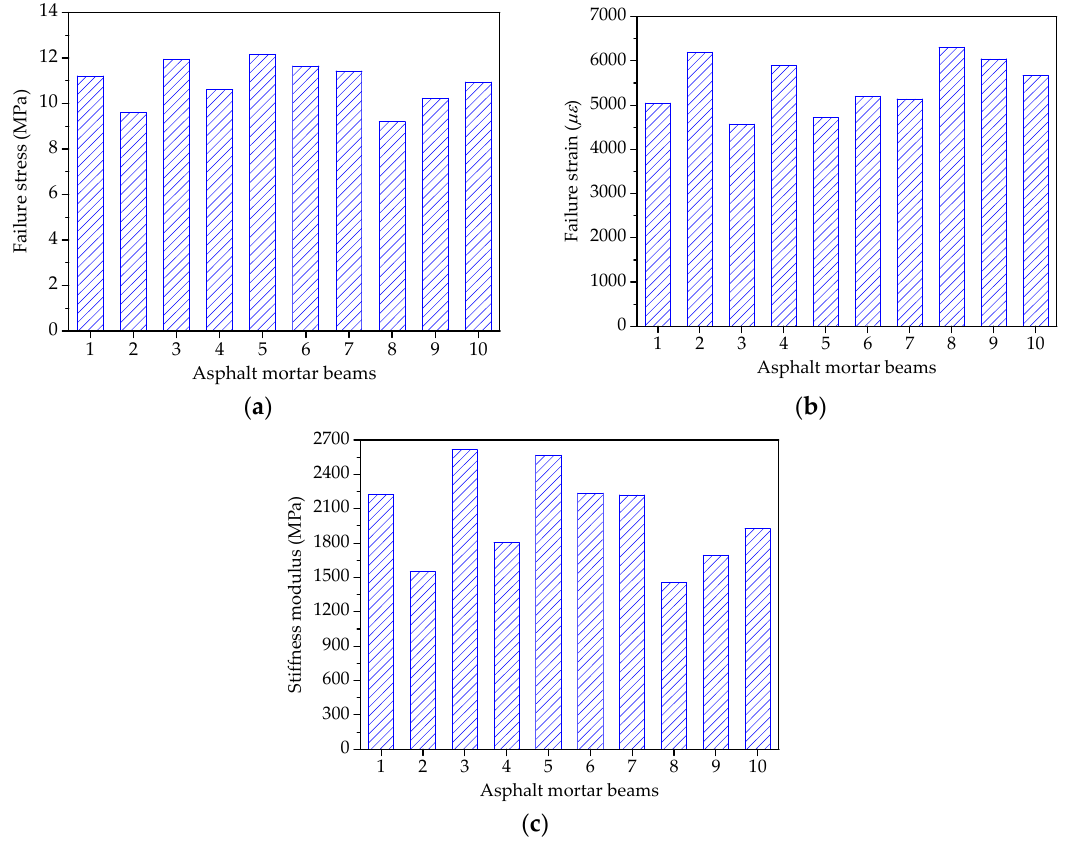
Figure 14. Failure results of asphalt mortar beams: ( a ) Failure stress; ( b ) Failure strain; and, ( c ) Stiffness modulus.